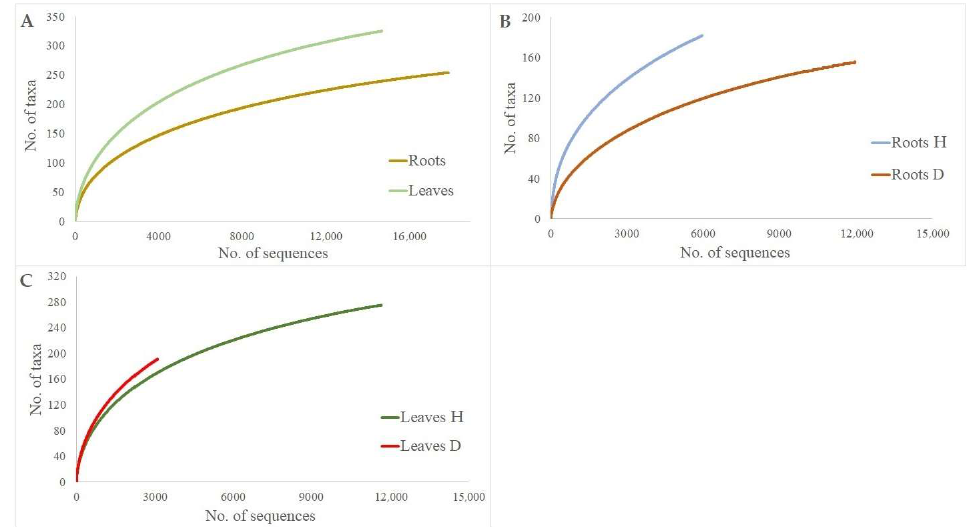
Figure 2. Species accumulation curves showing the relationship between the cumulative number of fungal taxa and the number of ITS rRNA sequences from Ulmus glabra root and leave samples: ( A ) total roots vs. total leaves; ( B ) roots of healthy trees (Roots H) vs. roots of diseased trees (Roots D); ( C ) leaves of healthy trees (Leaves H) vs. leaves of diseased trees (Leaves D). In leave and root samples from healthy-looking and diseased trees, the richness of fungal taxa varied among individual study sites Table 2. However, leaf samples from healthy-looking trees had a significantly higher fungal richness than those from DED-in- fected trees ( p < 0.05), and a significant difference was not detected between corresponding root samples ( p > 0.05).